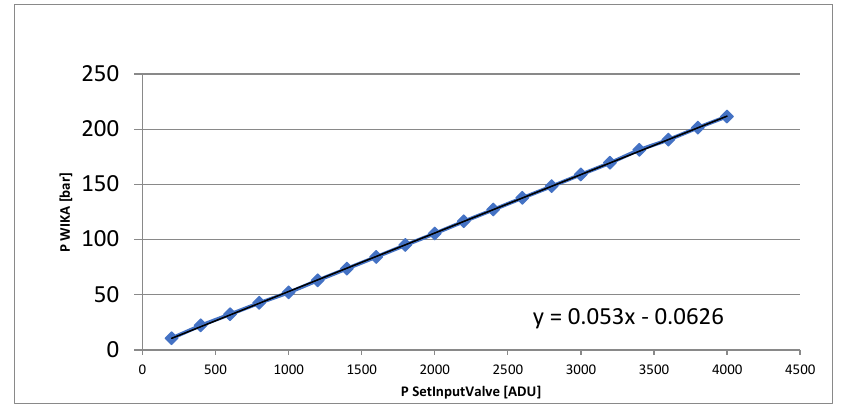
Figure 6. Measured transfer curve between output of pneumatic – hydraulic system pressure in bar units and control voltage for proportional pneumatic valve as input of system in ADU units (see Equation (2)).